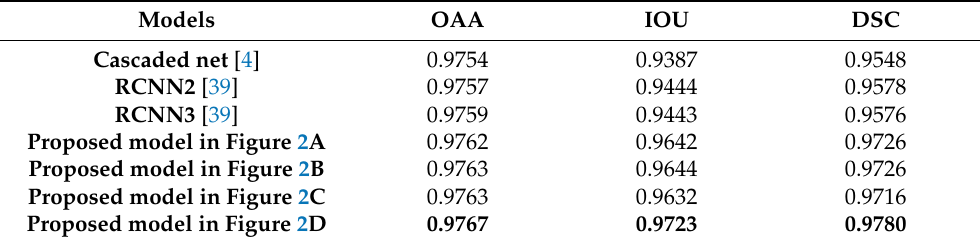
Table 3. Evaluation metrics of the models for centerline extraction. The results are the average of the performance for all epochs of all images in the test set. The bolded values are the highest.